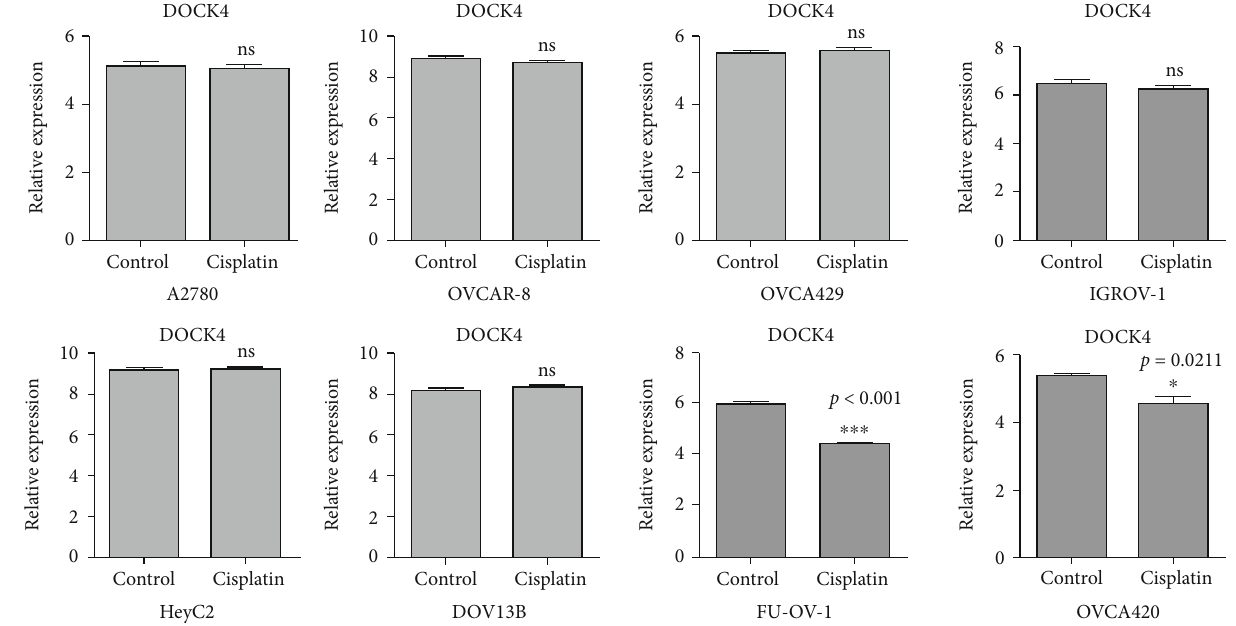
Figure 6: Changes in DOCK4 expression levels in some ovarian cancer cells treated with